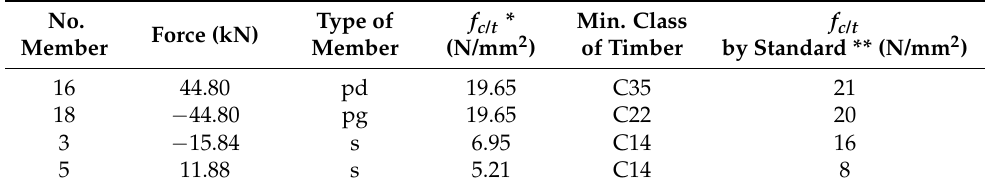
Table 2. The minimum strength.